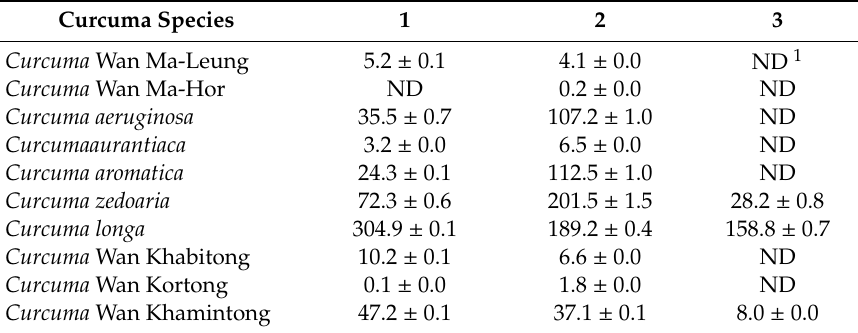
Table 3. Analysis of curcuminoids from the Curcuma species.